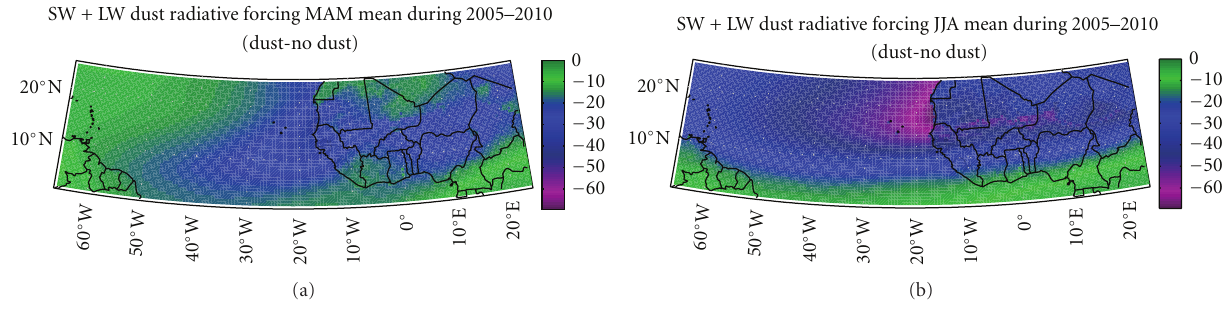
Figure 11: Solar radiation forcing (Longwave and shortwave) in W/m 2 due to the presence of dusts at the surface.